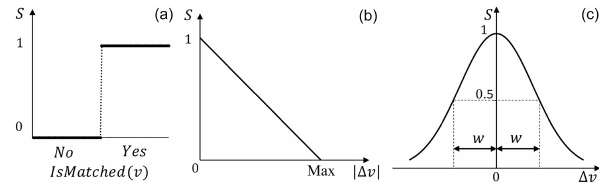
Figure 2. Basic kinds of similarity function: (a) Boolean function; (b) linear function; (c) bell-shaped